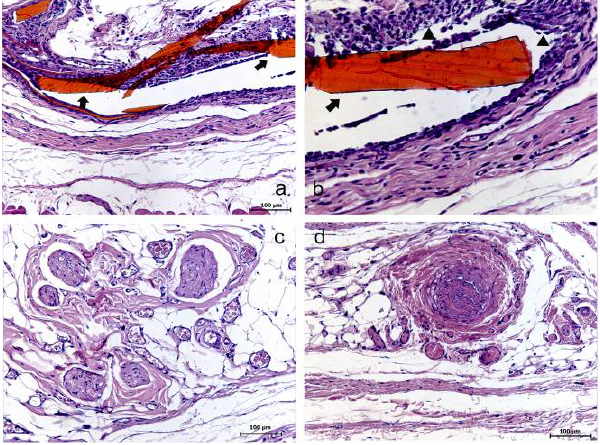
Figure 4. High molecular weight chitosan (HMWC) group at 7 ( a – b ), 15 ( c ) and 30 ( d ) days. ( a ) Evidence of the membrane (  ) and its surrounding (HE); ( b ) Evidence of the membrane (  ) involved with the presence of a reactional tissue associated with a chronic inflammatory cell infiltrate ( ▲ ) (HE); ( c ) Presence of collagen/fibroblastic disorganized tissue and no inflammatory reaction (HE); ( d ) Tissue presenting no evident alteration (HE).